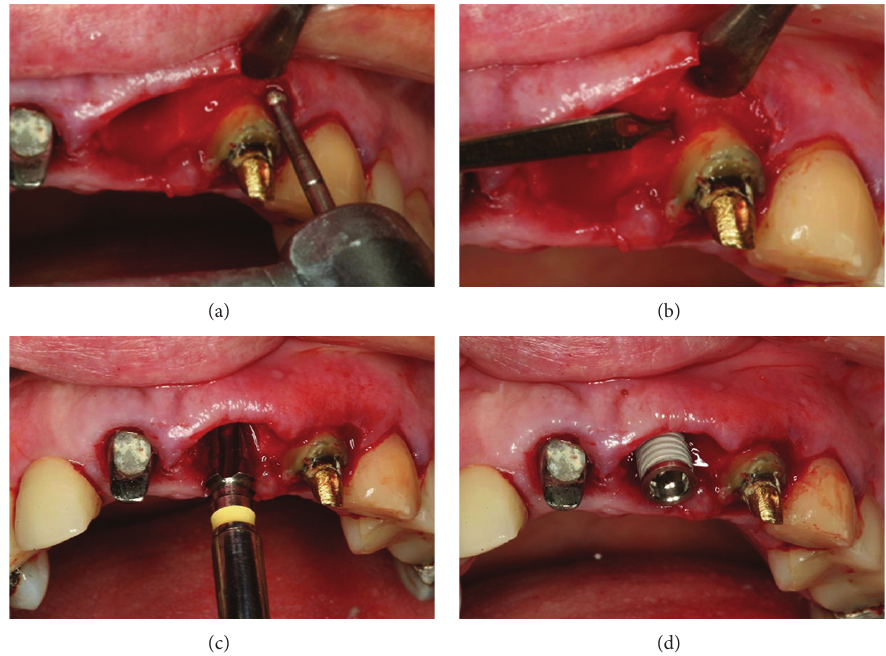
Figure 6: (a, b) After tooth extraction, root planing and curettage of the alveolus and bone removal for crown lengthening, with the aid of a chisel, were performed. (c, d) A 4.3 mm internal hexagon implant was placed 3mm below the alveolar bone crest in the direction of palatal cortical